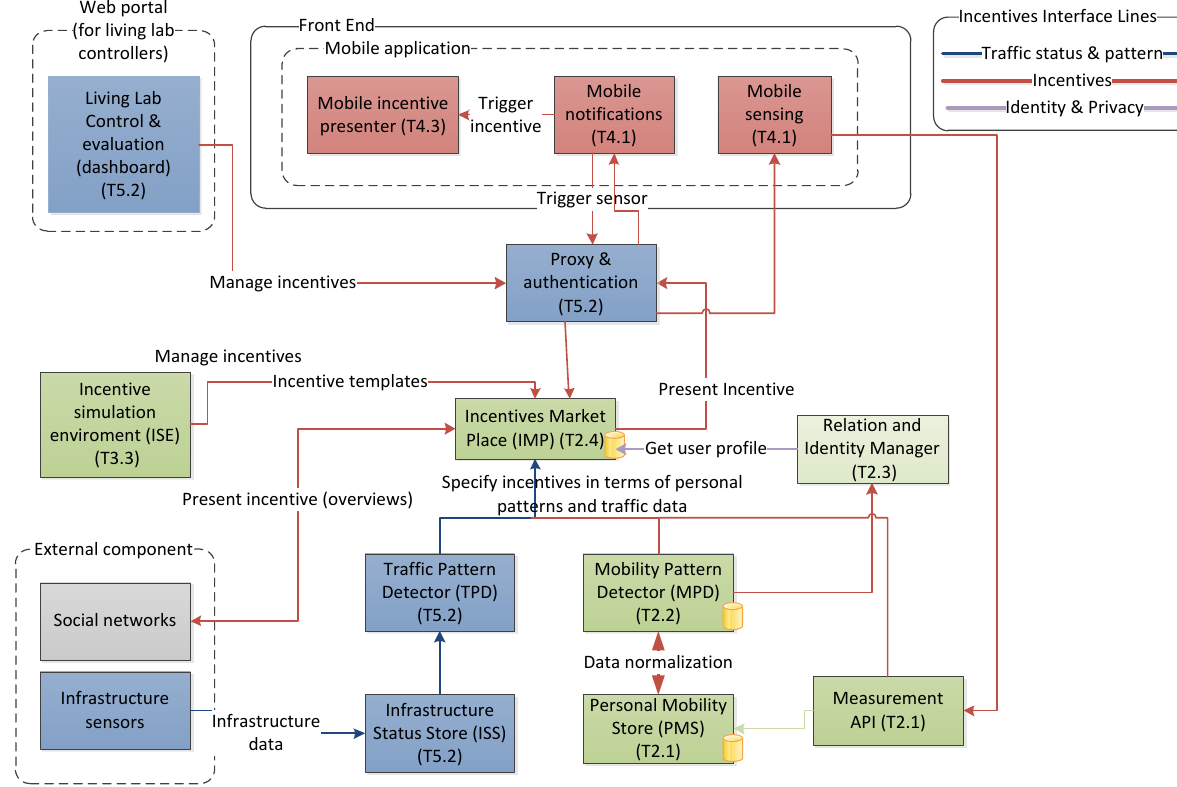
Figure 2. System interaction to support incentives distribution (the database symbol at the edge of some components indicates that that component is associated with an internal data store; T identifies the part of the project, the task, that developed that